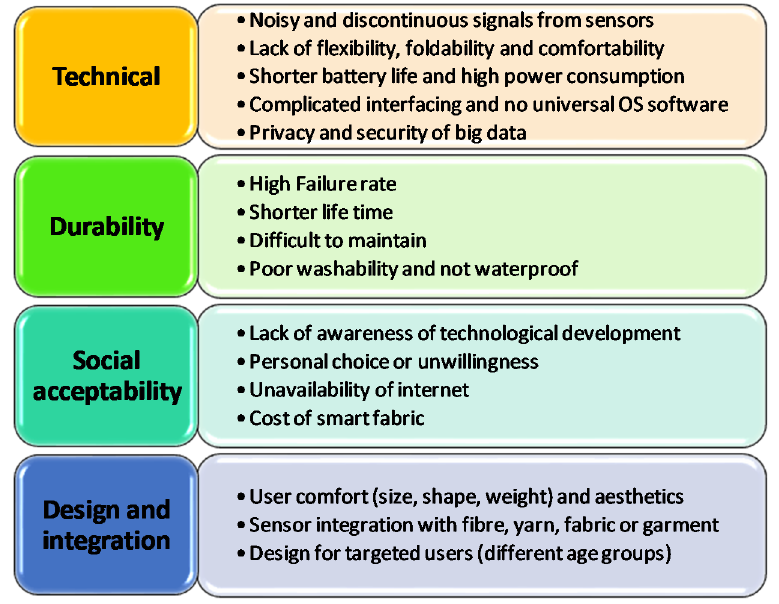
Figure 19. Challenges of wearable technology in smart clothing from various perspectives.